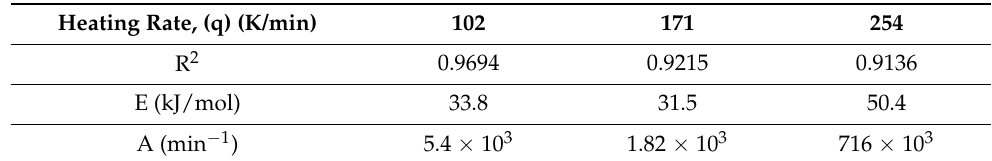
Table 6. Effect of heating rate (q) on the kinetic parameters E, A.